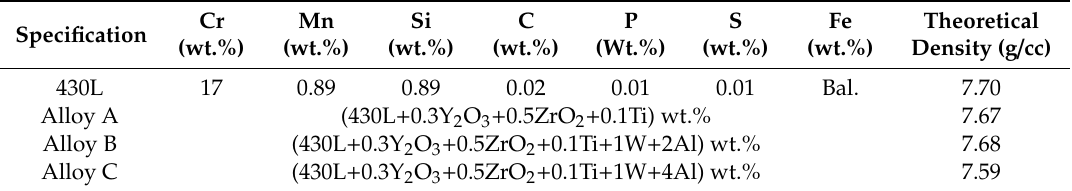
Chemical composition of the three oxide dispersion strengthened ferritic stainless steel